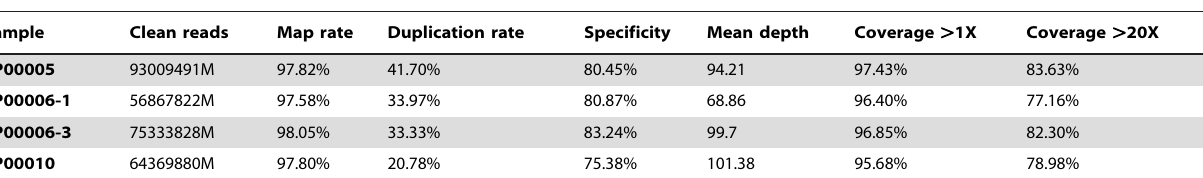
Table 2. Data summary of the 3 YH libraries.